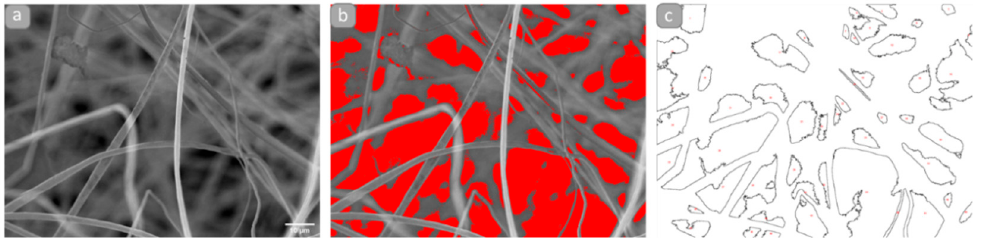
Figure 2. SEM images processed for bidimensional pore space segmentation. Representative images of rPLA scaffold, in ( a ) original image, ( b ) applied threshold, ( c ) detected